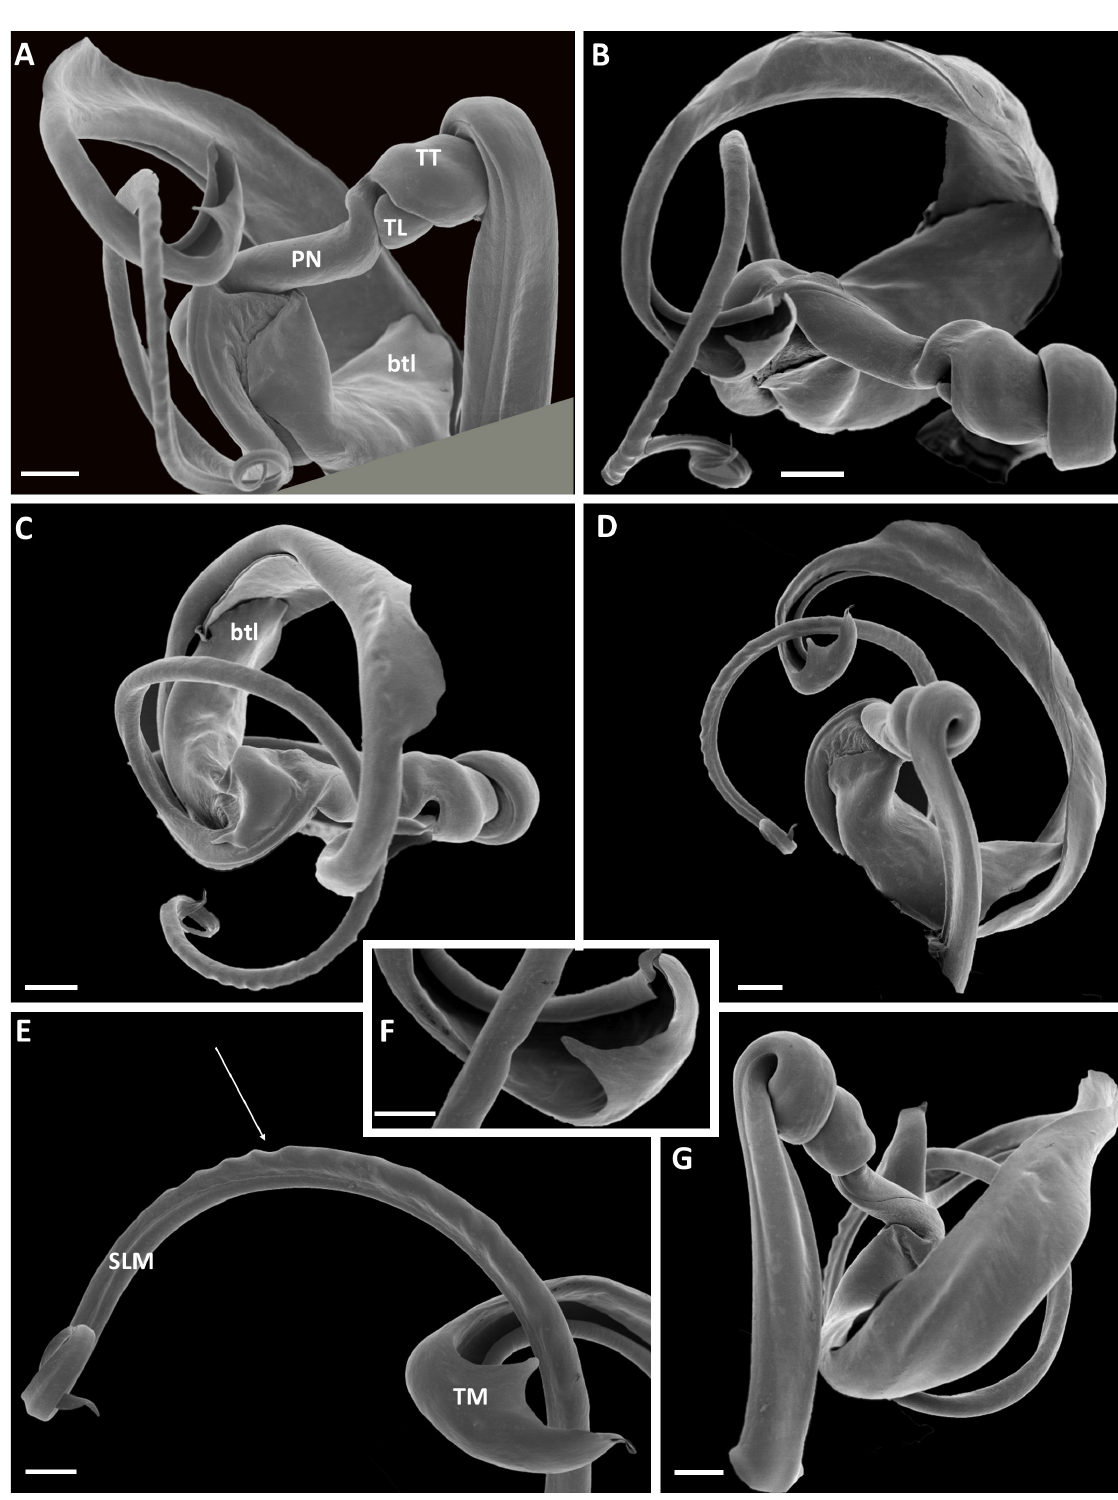
Fig. 39. Geotypodon cristinae sp. nov., holotype, ♂ (NHMD 621736). Left gonopod telopodite. A . Posterior view. B . Ventral view. C . Meso-ventral view. D . Lateral view. E . Distal parts of solenomere and telomere, arrow points to ‘wavy’ surface. F . Tip of telomere (crossed by solenomere). G . Latero-anterior view. Abbreviations: btl = basal telomeral lamella; PN = post-torsal narrowing; SLM = solenomere; TL = torsotope lobe; TM = telomere; TT = torsotope . Scale bars: A–D, G = 0.2 mm; E–F = 0.1